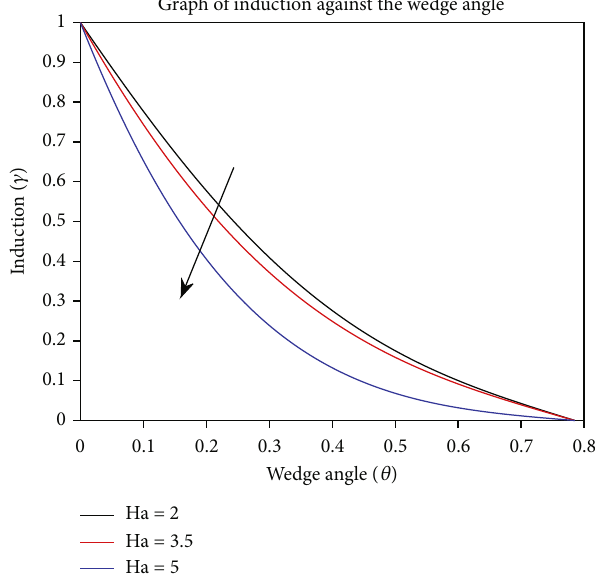
Figure 10: E ff ect of varying the Hartmann number on magnetic